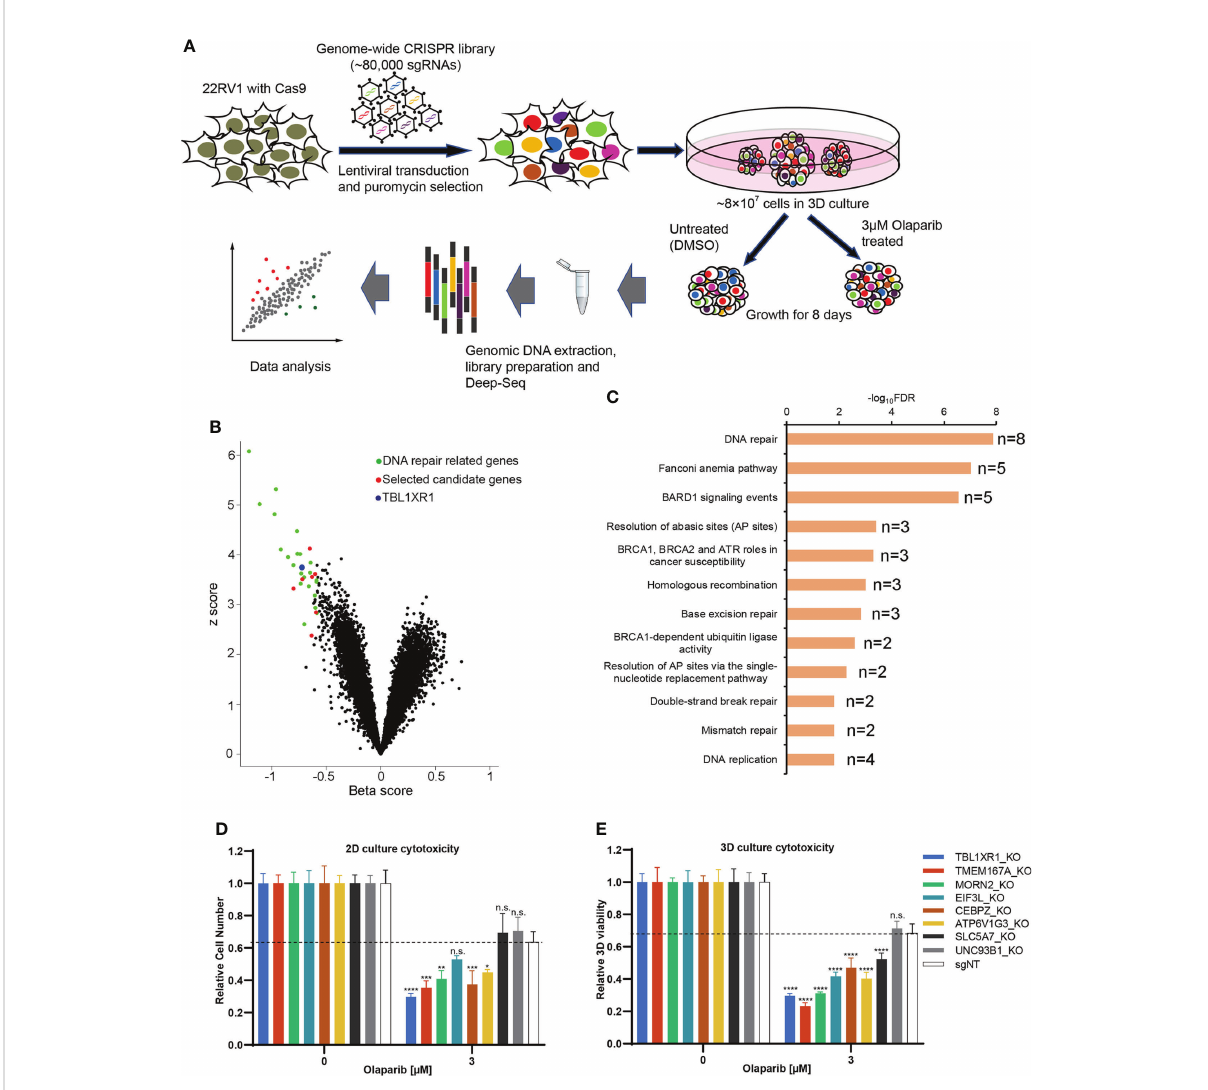
FIGURE 1 CRISPR screen of prostate cancer line in 3D culture. (A) The diagram of steps involved in CRISPR screen in 3D culture. (B) Volcano plot of CRISPR screening analysis. Values on the x-axis show the beta score of each gene and the y axis shows absolute z score (see Methods). Previously identi fi ed DNA repair genes were labeled in green and selected novel candidate genes were labeled in red. TBL1XR1 is labeled in blue. (C) Enriched pathways among the top 46 hits (FDR<0.05, beta<-0.2) from negative selection using the BioPlanet 2019 database set of Enrichr (see Methods). (D, E) Selected top candidate hits were validated with individual sgRNAs in 2D (D) and 3D (E) cytotoxicity assays. Data are mean ± s.e.m., n = 3; *p < 0.05, **p < 0.01, ***p < 0.001, and ****p < 0.0001; n.s., not signi fi cant, which were calculated by two-sided t-test between the control (sgNT) and gene-targeting